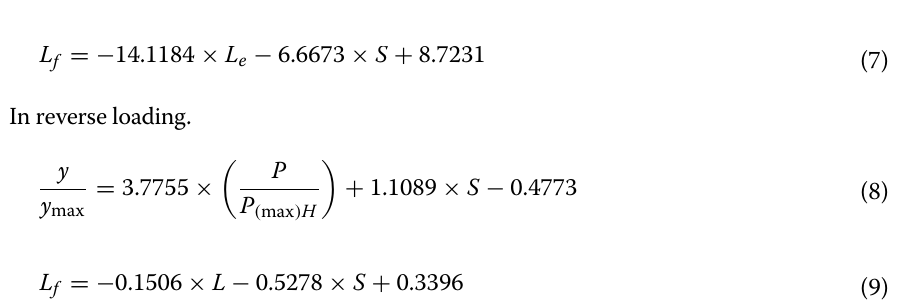
Table 2 Values of P/P (max)H Slope P/P(max)H Forward Loading Reverse Loading 1V:3H